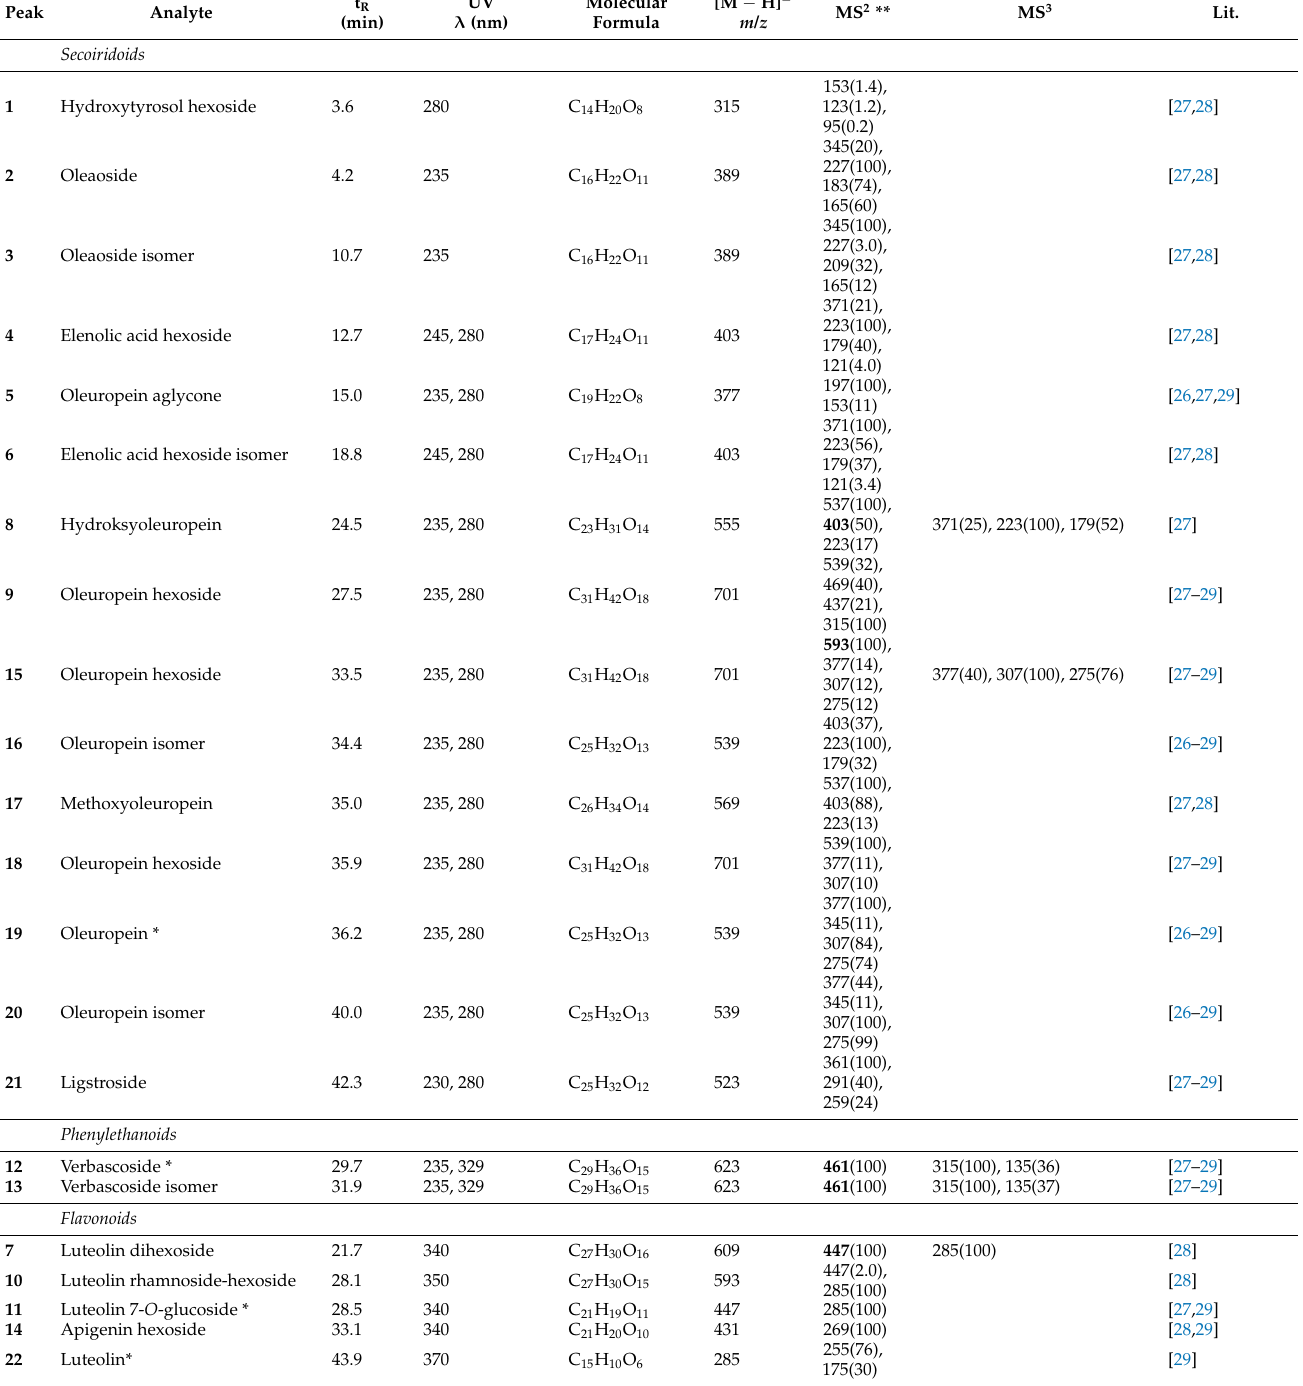
Table 1. UHPLC-PDA-ESI-MS 3 data of polyphenols identified in the commercial O. europaea leaf